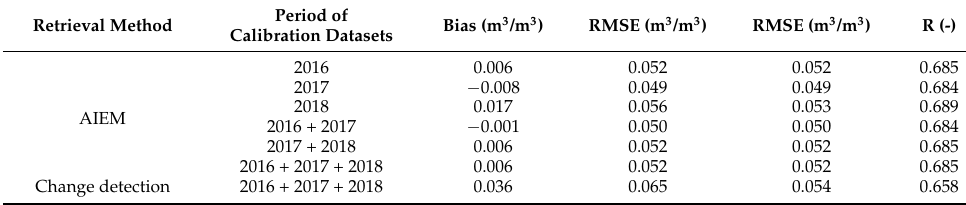
Table 5. Statistical errors computed between the in situ measurement and SM retrievals.